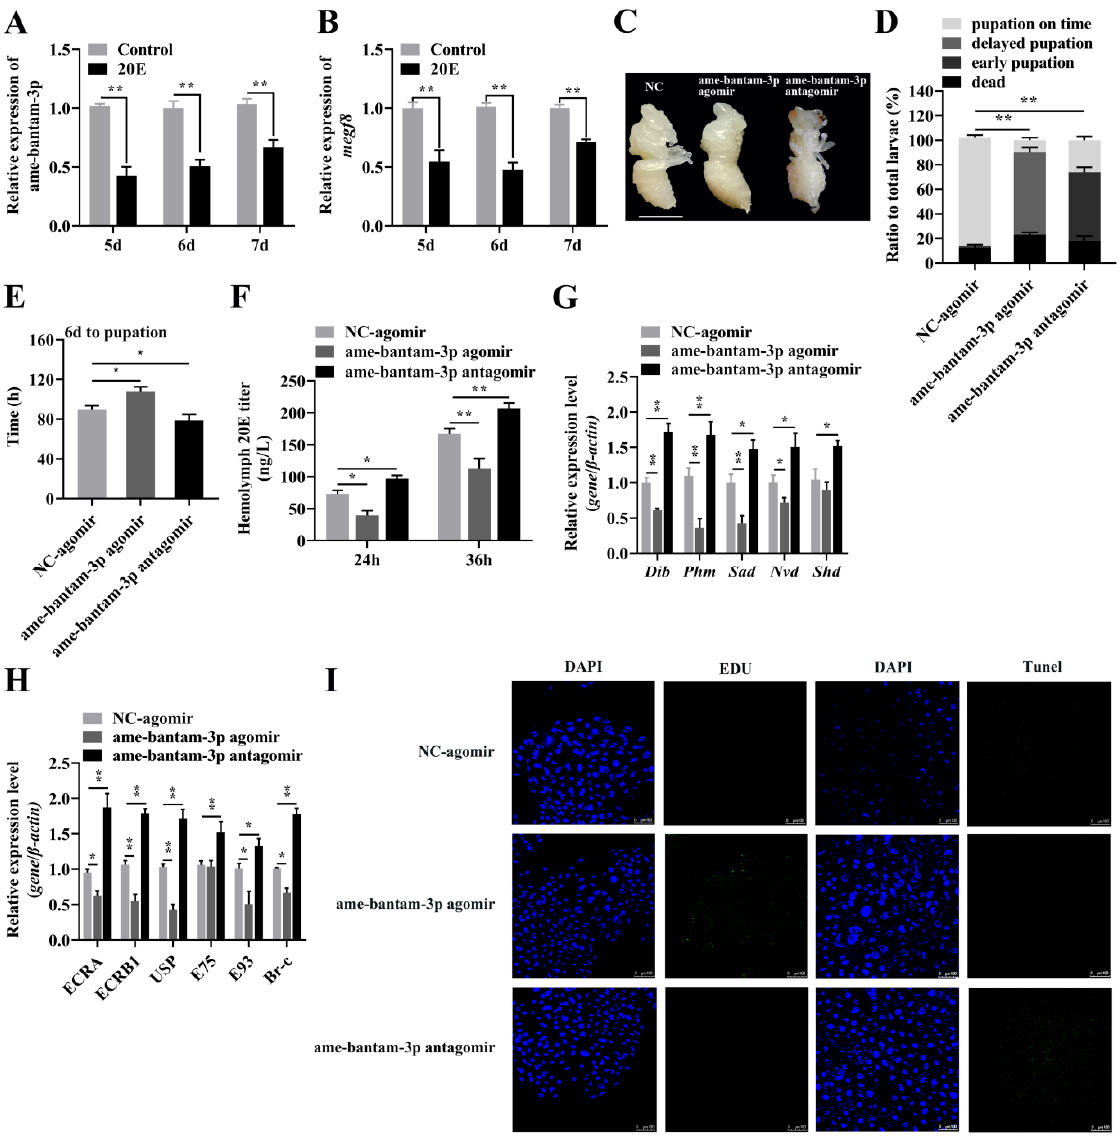
Figure 8. The effects of exogenous 20-hydroxyecdysone (20E) application on the expression profiles of ame-bantam-3p ( A ) and megf8 ( B ) five, six, and seven days after feeding. ( C ) Phenotypeassessment after ame-bantam-3p agomir or ame-bantam-3p antagomir injection. The ruler represents 0.3 cm. ( D ) Percentage distribution of different phenotypes. ( E ) Statistical analysis of the time of development of six-day old larvae to pupae. ( F ) The determination of the 20E titer 24 and 36 h after miRNA agomir or antagomir injection. The expression levels of genes essential for ecdysteroid synthesis ( G ) and 20E signaling pathway genes ( H ) 24 h after ame-bantam-3p agomir or ame-bantam-3p antagomir injection. ( I ) Representative image of fat body cell proliferation and apoptosis. The EdU assay was performed 24 h after agomir or antagomir injection into the hemocoel. TUNEL staining showing the morphology of the fat body. Bar indicates 100 μ m. Error bars indicate the SEM.* p < 0.05, ** p < 0.01 compared with the relevant control (two-tailed t -test).